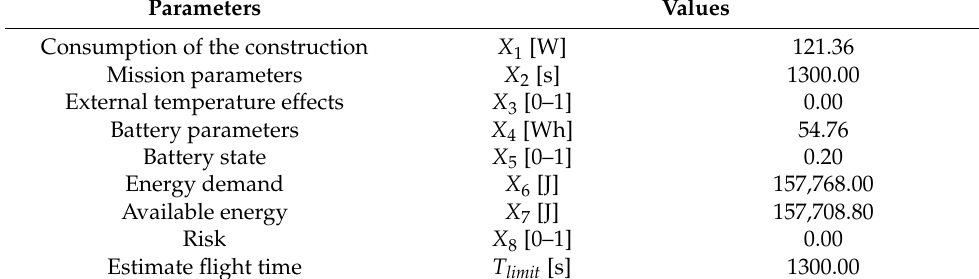
Table 6. Values of the parameters before take-off.